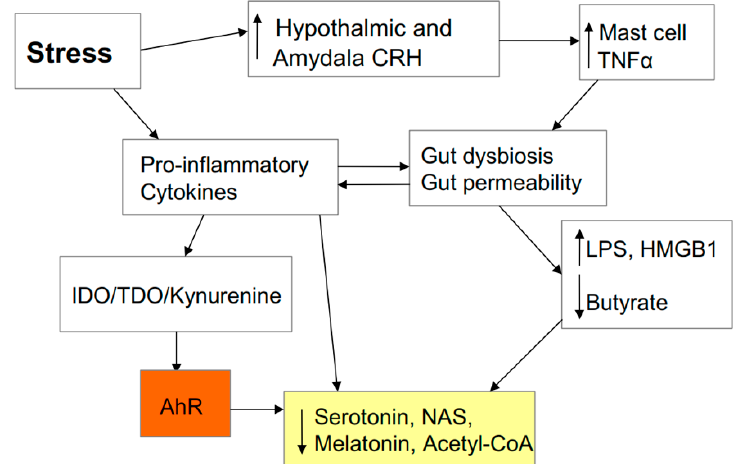
Figure 4. Stress increases hypothalamic and amygdala corticotropin-releasing hormone (CRH) release, thereby activating mucosal mast cells to release tumour necrosis factor (TNF) α , which increases gut permeability/dysbiosis. This leads to an increase in the toll-like receptor (TLR) 4 agonists lipopolysaccharide (LPS) and high-mobility group box (HMGB) 1, which decrease pineal melatonin production, thereby dysregulating the circadian regulation of optimized immune cell function. Decreased butyrate will also lower melatonin and acetyl-CoA production as well as contributing to suboptimal mitochondrial function. Stress, partly by increasing gut permeability/dysbiosis and pro-inflammatory cytokines, leads to an increase in the conversion of tryptophan to kynurenine, thereby lowering serotonin, N-acetylserotonin (NAS), and melatonin levels. Stress, in its many manifestations, is therefore intimately linked to pathways pertinent to the regulation of SARS-CoV-2 severity/fatality.